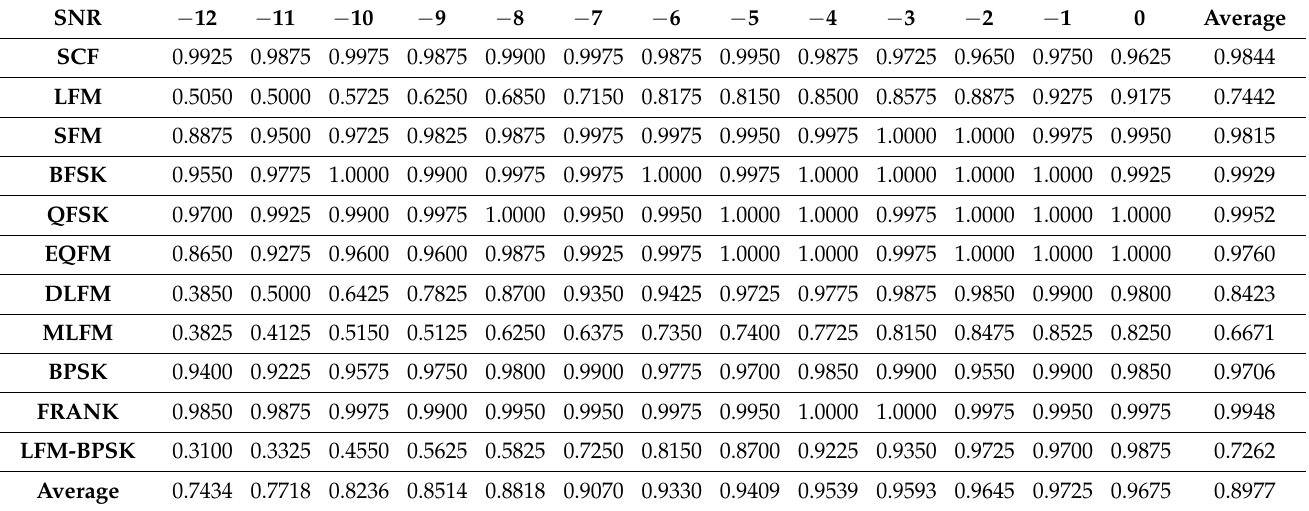
Table A30. Semi-supervised classification results of our proposed method with the datasets in Situation Dataset 5.